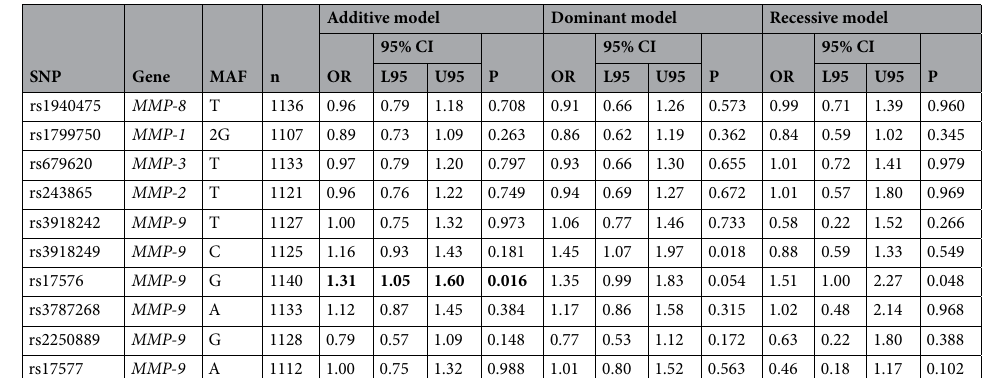
Table 2. Associations of the MMP gene polymorphisms with PUD. All results were obtained after adjustment for covariates. p values < 0.017 are shown in bold. OR odds ratio, 95% CI 95% confidence interval.